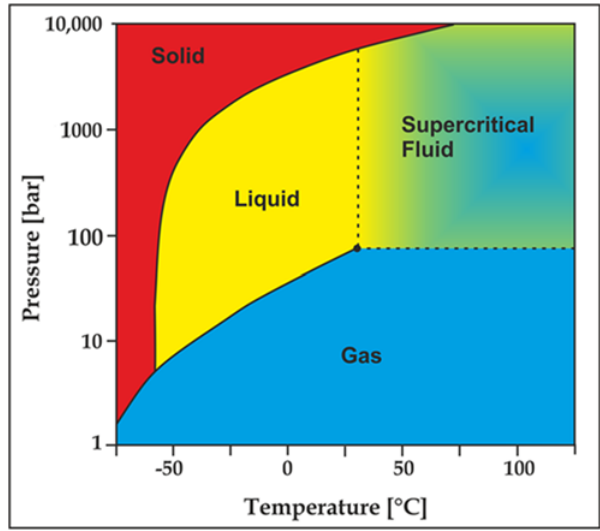
Figure 10 . CO 2 thermodynamic behaviour chart [84]. Figure 10. CO 2 thermodynamic behaviour chart